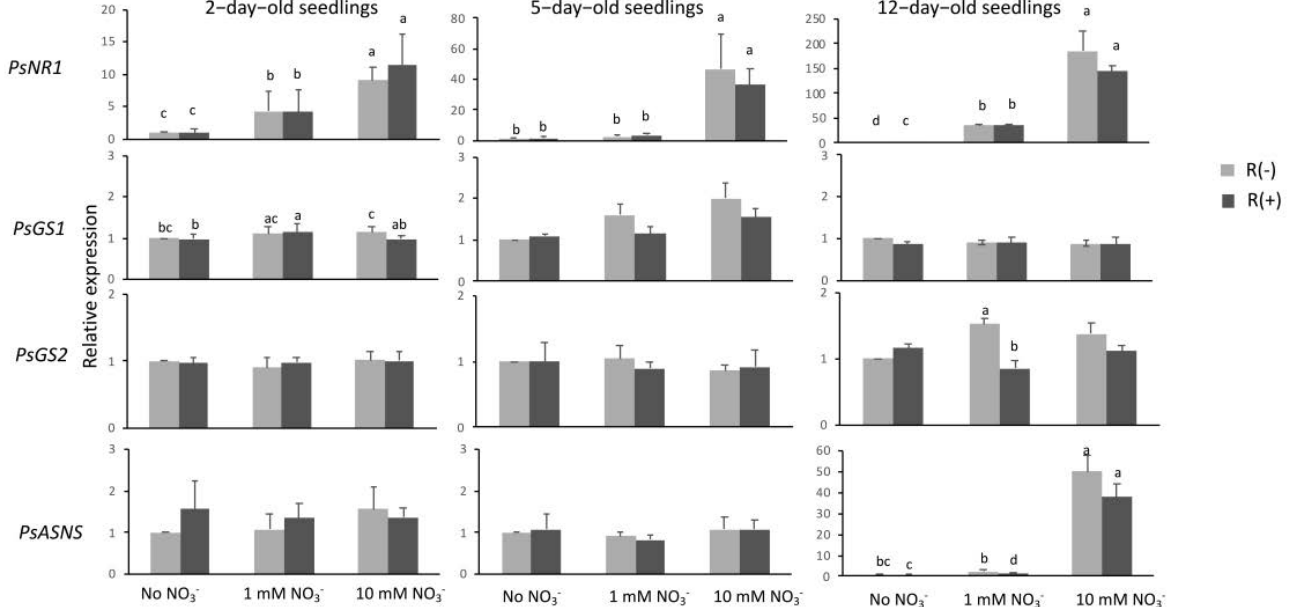
Figure 4. Relative expression of genes encoding enzymes of nitrate metabolism. The samples and the conditions used for RT-qPCR experiments were the same as those described in the legend of Figure 1. PsNR1 , nitrate reductase; PsGS1 , cytosolic glutamine synthetase; PsGS2 , plastidic glutamine syn- thetase; PsASNS , asparagine synthetase. Data presented are means of three independent experiments performed in triplicate. Error bars indicate SE. Letters denote significant differences at the 0.05 level (multiple